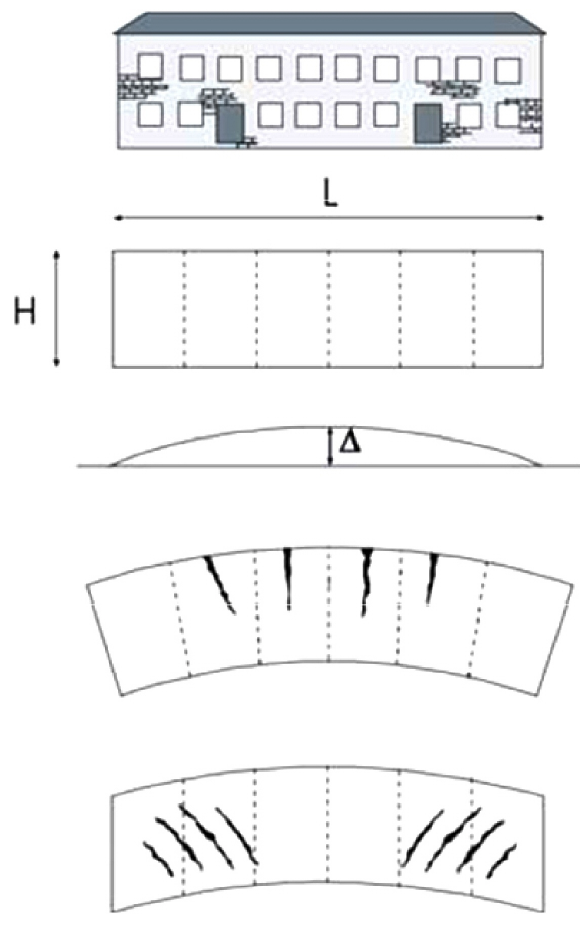
Fig. 1. Illustration of the equivalent Deep Beam Method, used to replace an actual building by a uniform, weightless, elastic beam of unit thickness (Burland and Wroth,